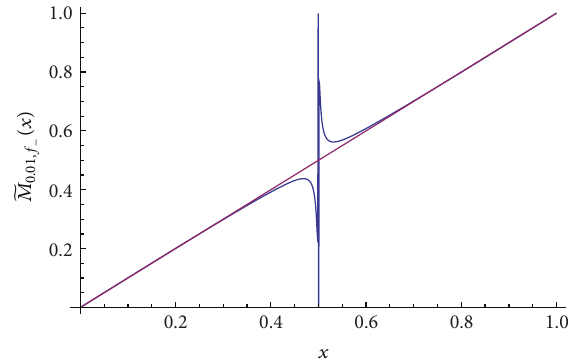
̃𝑀 𝜆 = 0.01 , where the BZ interval is 𝜆,𝑓 − with